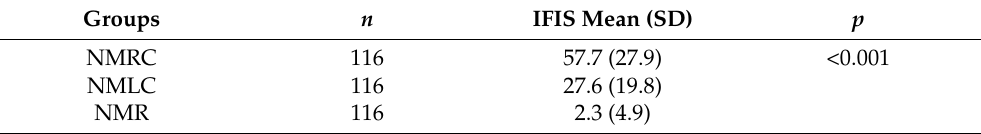
Table 2. Semiquantitative MAPLC3 protein expression in normal colorectal mucosa of patients under- going colonoscopy, by immunofluorescence and confocal microscopy analyses (immunofluorescence intensity score, IFIS). NMRC, normal mucosa of the right colon; NMLC, normal mucosa of the left colon; NMR, normal mucosa of the